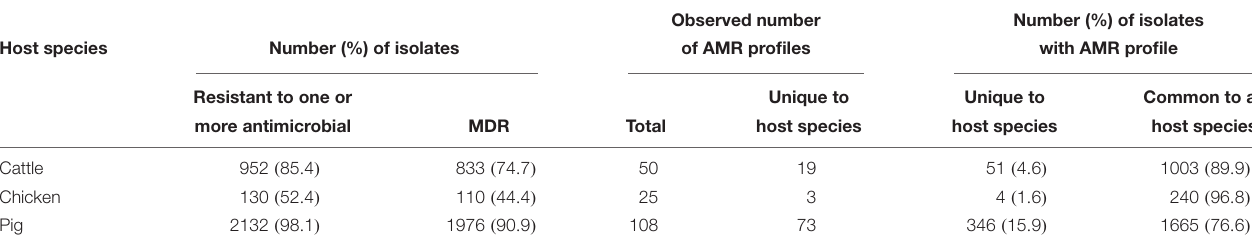
TABLE 3 | Summary of prevalence of resistance to one or more antimicrobial, multi-drug resistant (MDR), and comparison of AMR profiles observed for each host species.